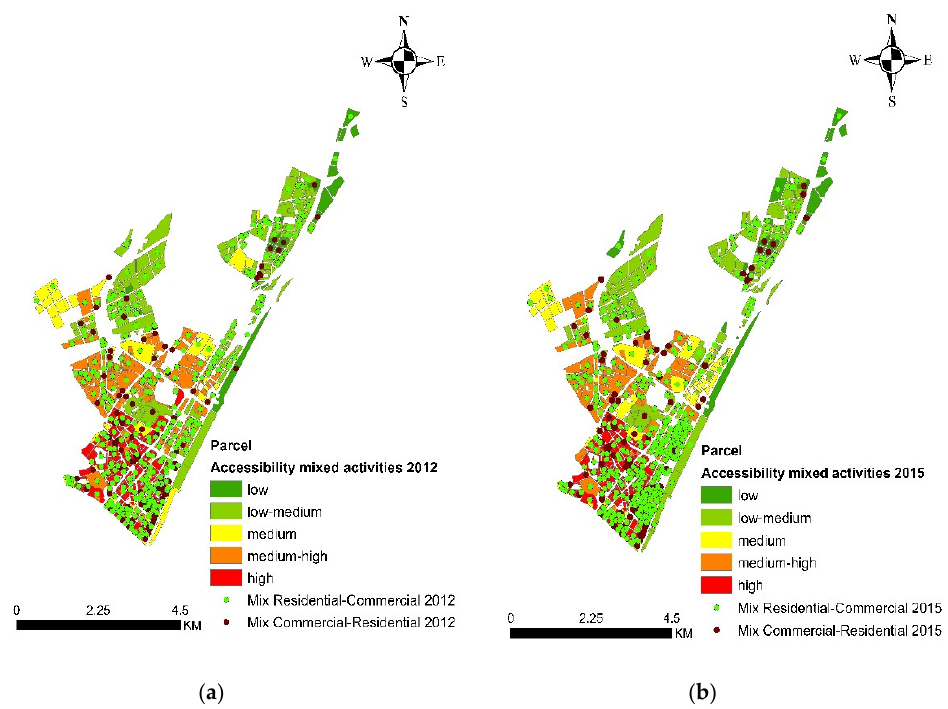
Figure 11. ( a , b ) Accessibility to mixed activities and mixed space developed at parcel level: ( a ) accessibility to mixed activities (2012); and ( b ) accessibility to mixed activities (2015). Table 4. The total number of the buildings changed from 2012 to 2015 by parcel type in the Jiang’an